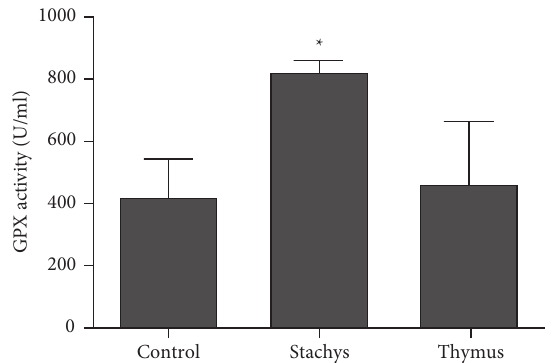
Figure 7: S. pilifera Benth and T. daenensis Celak extracts on glutathione peroxidase (GPX) activity for 24h in HepG2 cells ( ∗ P < 0 . 05, in comparison to the